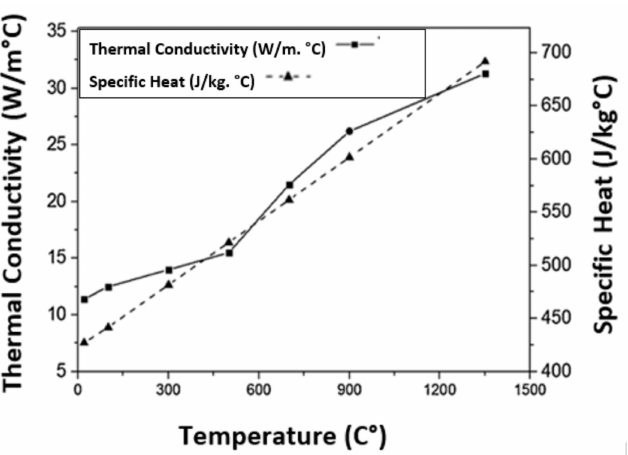
Figure 6. Thermal conductivity and heat capacity of Inconel 718 as a function of temperature (adopted from [30] with kind permission from